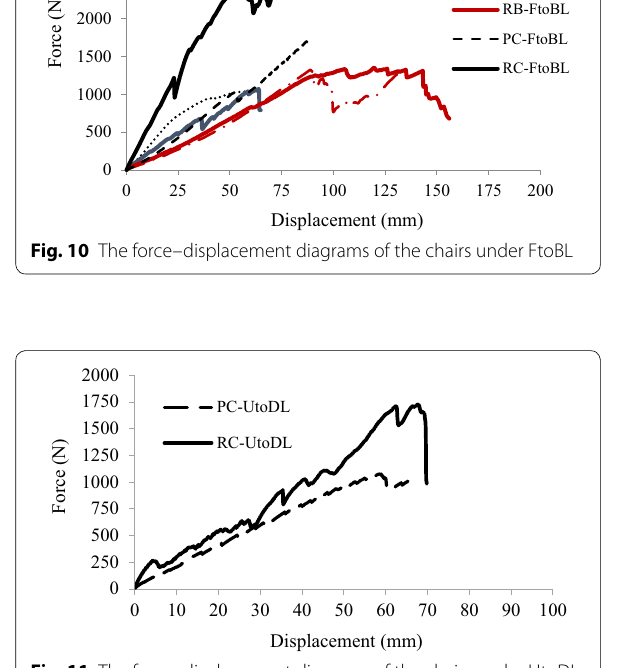
Fig. 11 The force–displacement diagrams of the chairs under UtoDL